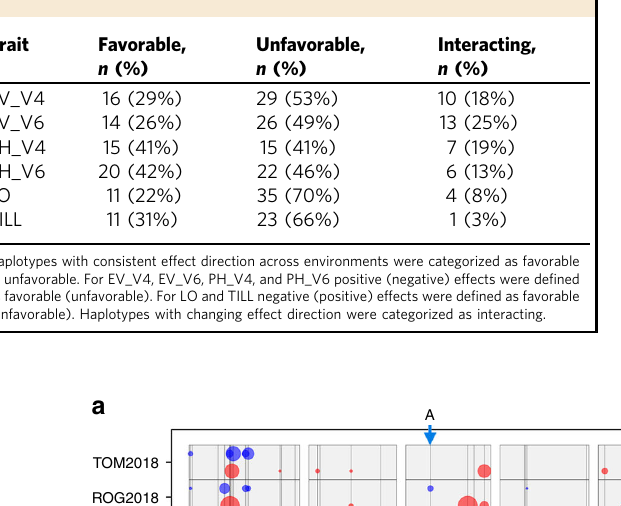
Table 1 Number and percentage of favorable, unfavorable, and interacting focus haplotypes per trait.